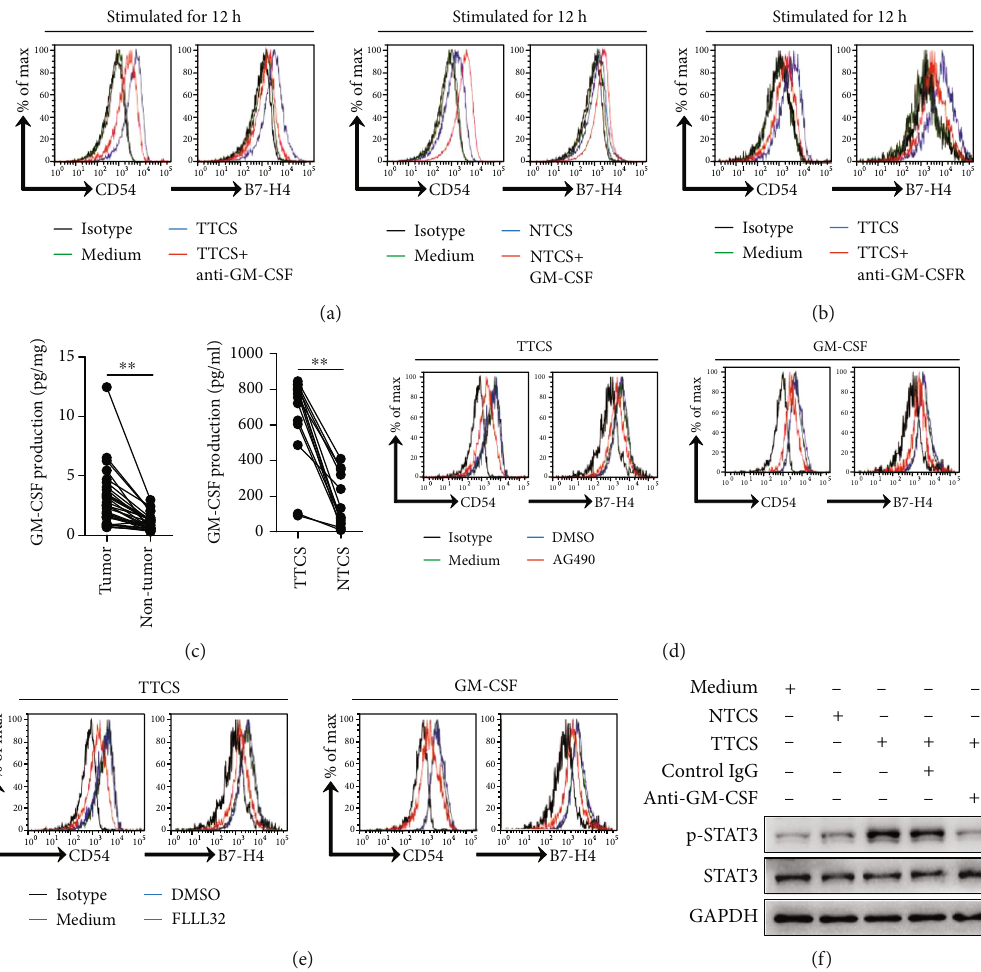
Figure 5: Tumor-derived GM-CSF activates neutrophils and induces B7-H4 expression on neutrophils via activating the JAK-STAT3 pathway. (a) Expressions of CD54 and B7-H4 on neutrophils exposed to 50% TTCS with anti-GM-CSF antibody or 50% NTCS with GM- CSF for 12 h. Black: isotype control. (b) Expressions of CD54 and B7-H4 on neutrophils exposed to 50% TTCS pretreated with anti-GM- CSF receptor (GM-CSFR) antibody for 12 h. Black: isotype control. (c) GM-CSF concentration between autologous tumor and nontumor tissues ( n = 31 ) or between autologous TTCS and NTCS ( n = 14 ) was analyzed. (d) Expressions of CD54 and B7-H4 on neutrophils exposed to 50% TTCS or GM-CSF with or without JAK signal transduction inhibitor AG490 for 12h. (e) Expressions of CD54 and B7-H4 on neutrophils exposed to 50% TTCS or GM-CSF with or without STAT3 phosphorylation inhibitor FLLL32 for 12 h. (f) STAT3 and p- STAT3 in neutrophils exposed to 50% TTCS and 50% NTCS from autologous GC patients, or to medium control, or to 50% TTCS with anti-GM-CSF antibody or control IgG were analyzed by western blot. Each dot in (b) represents 1 patient. ∗ P < 0 : 05 for groups connected by horizontal